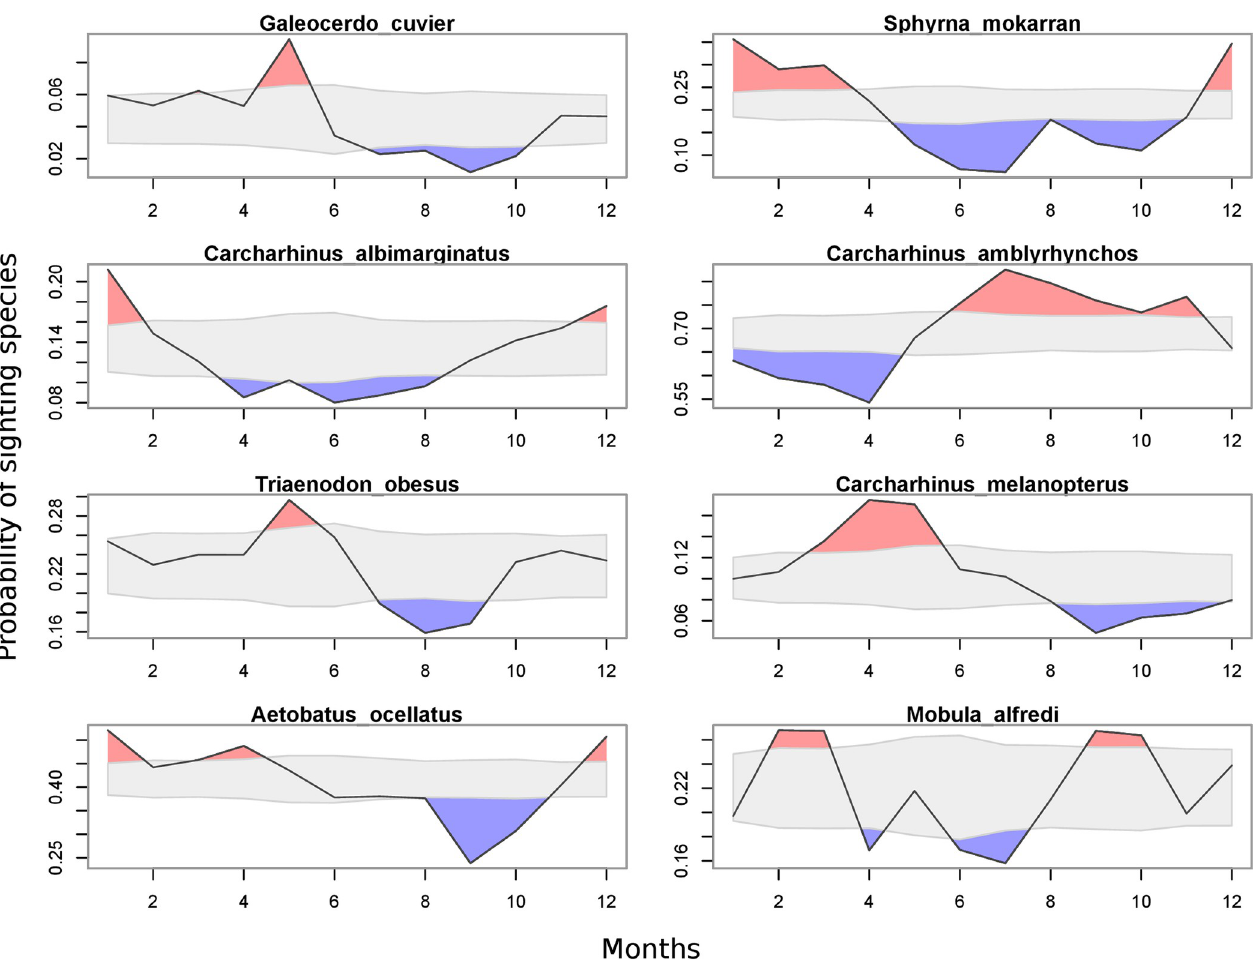
Fig 8. Yearly probability of sighting for eight elasmobranch species frequently encountered in the Tiputa Pass (Rangiroa). Solid black lines denote observed yearly sighting probability for each species. The gray-shaded polygon indicates the 95% range of the distribution of random sampling. Colored polygons highlight where the observed probability is above (red) or below (blue) the probability of observing that species if they were observed randomly.